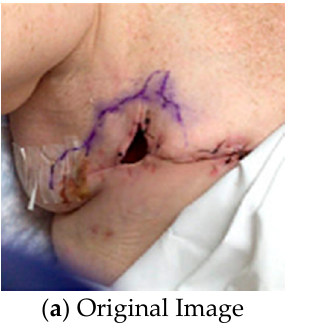
Figure 11. The probabilities of wound types: Pressure injury: 27.3%, lymphovascular: 12%, surgical: